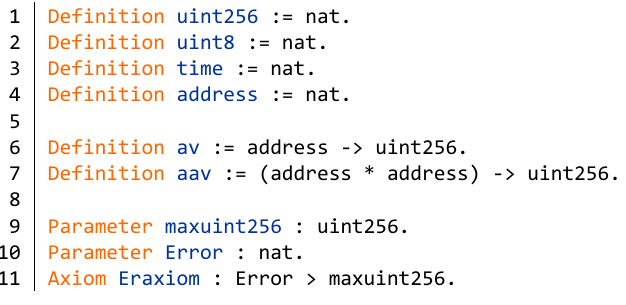
Figure 4. Basic data types of smart contracts.